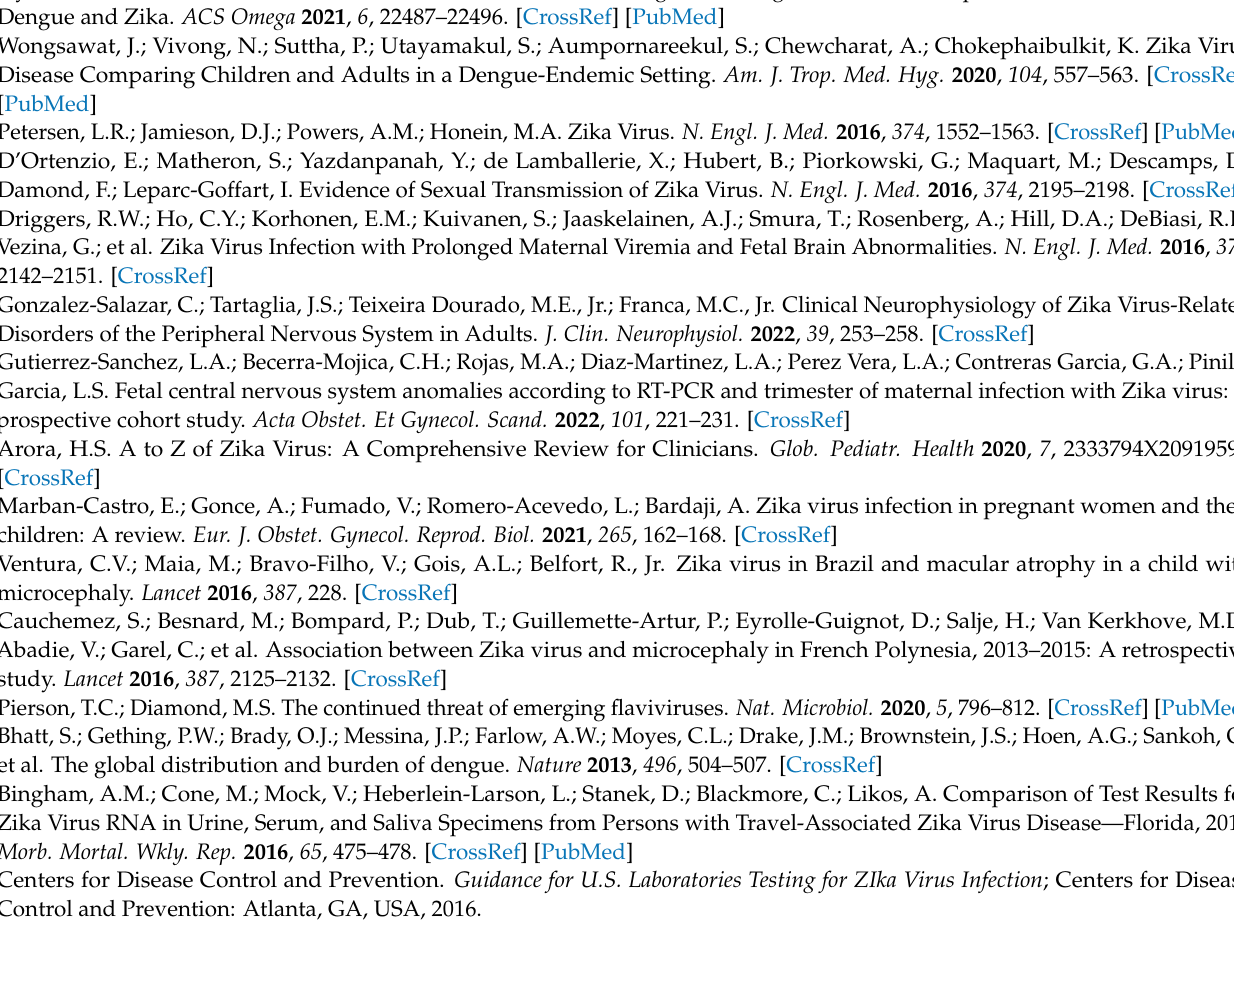
Table S2. Specificity of the CHORUS Dengue IgM capture